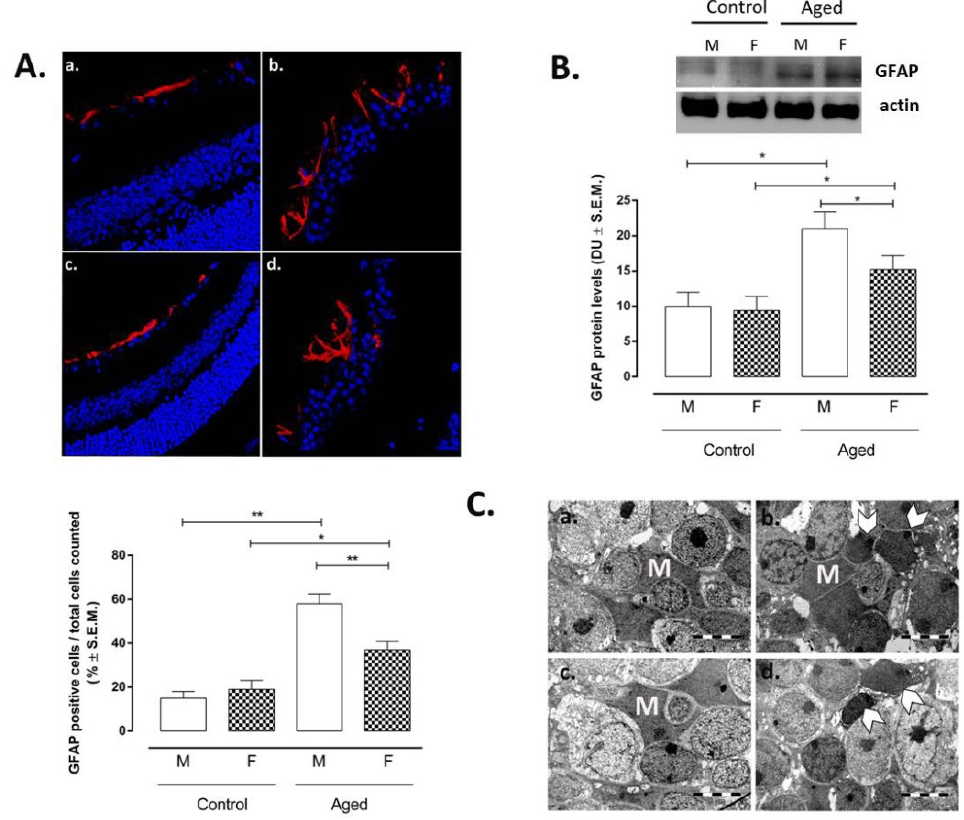
Figure 3. Müller cell activation in aged retina. ( A ) Immunofluorescence staining in control and aged retina. Immunofluorescence images and data (% ± S.E.M.) are representative of 10 observations for each individual/group; significantly increased GFAP immunoreactivity was noted in aged retinas (b. male; d. female), compared with the normal controls (a. male; c. female); ** p < 0.01; * p < 0.05 vs. control; magnification 63 × ; ( B ) Western blotting results are expressed as the mean ± S.E.M. of n = 10 retinas per group. M: males; F: females; DU: densitometric units; ** p < 0.01; * p < 0.05 vs. control; ( C ) electron microscopy evidenced a normal aspect of the Müller cells processes between bipolar cells in the inner nuclear layer (INL) of the controls (a. control male, c. control female) and extended network of cytoplasmic process of Müller cells (M); in both aged retinas (b. aged male; d. aged female); hypertrophied Müller cells (arrows); bar 5 µm.